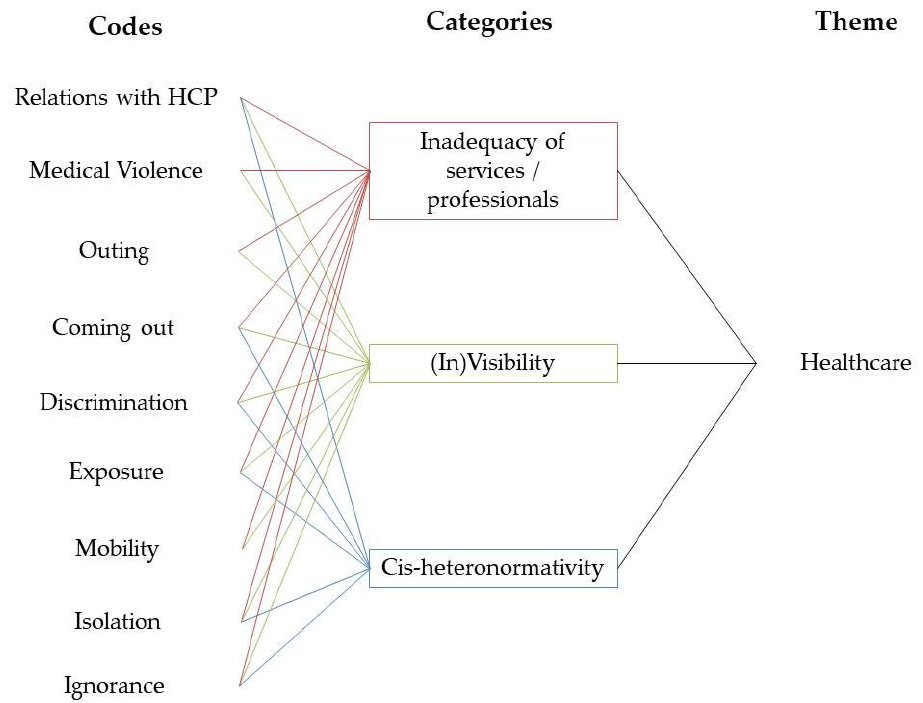
Figure 1. Thematic network of data analysis.